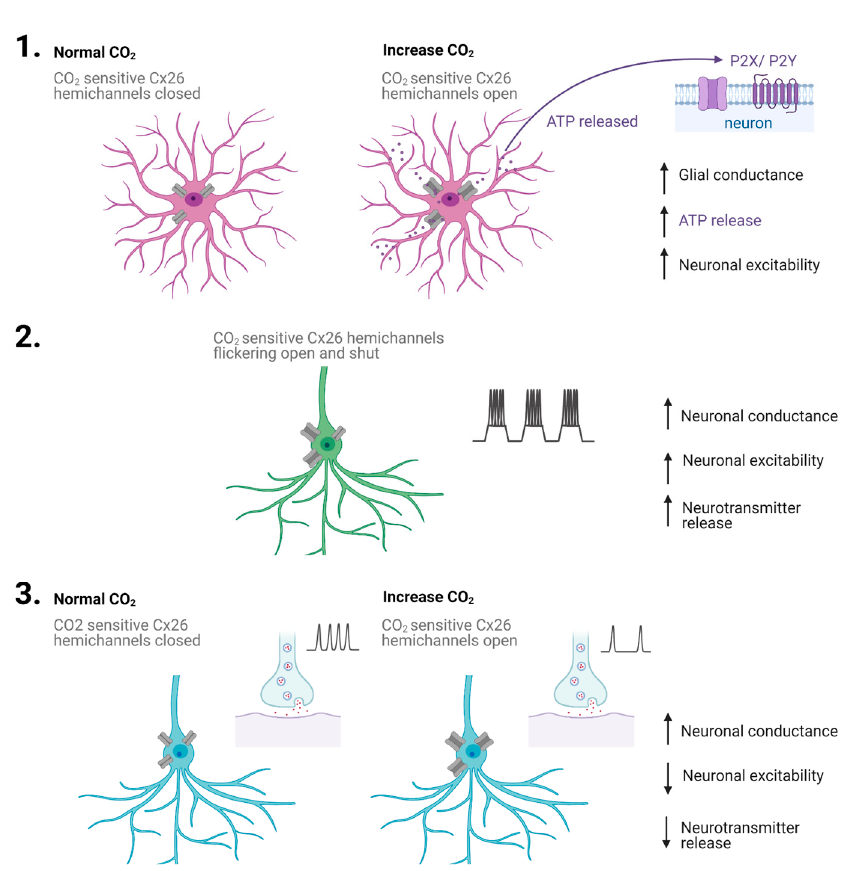
Figure 4. We propose that connexin 26 (Cx26) has three signalling modes: (1) In glia, when CO 2 is increased, Cx26 hemichannels will open, resulting in the release of ATP, which can then bind and signal through P2X ionotropic and P2Y metabotropic receptors on neighbouring neurons and glial cells, increasing the excitability. (2) In developing cortical neurons, the flickering of hemichannels from closed to open may lead the depolarising plateau potentials, which are important for development. This flickering may occur when CO 2 is at basal levels. (3) In young substantia nigra neurons and adult VTA neurons, increases in CO 2 levels lead to a stable increase in neuronal conductance and a decrease in neuronal excitability, which will result in a reduction of neurotransmitter